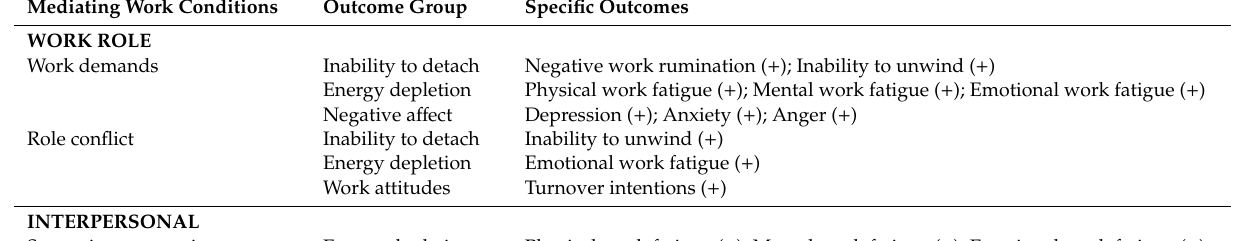
Table 5. Mapping statistically significant mediating work conditions to employee outcome groups and specific